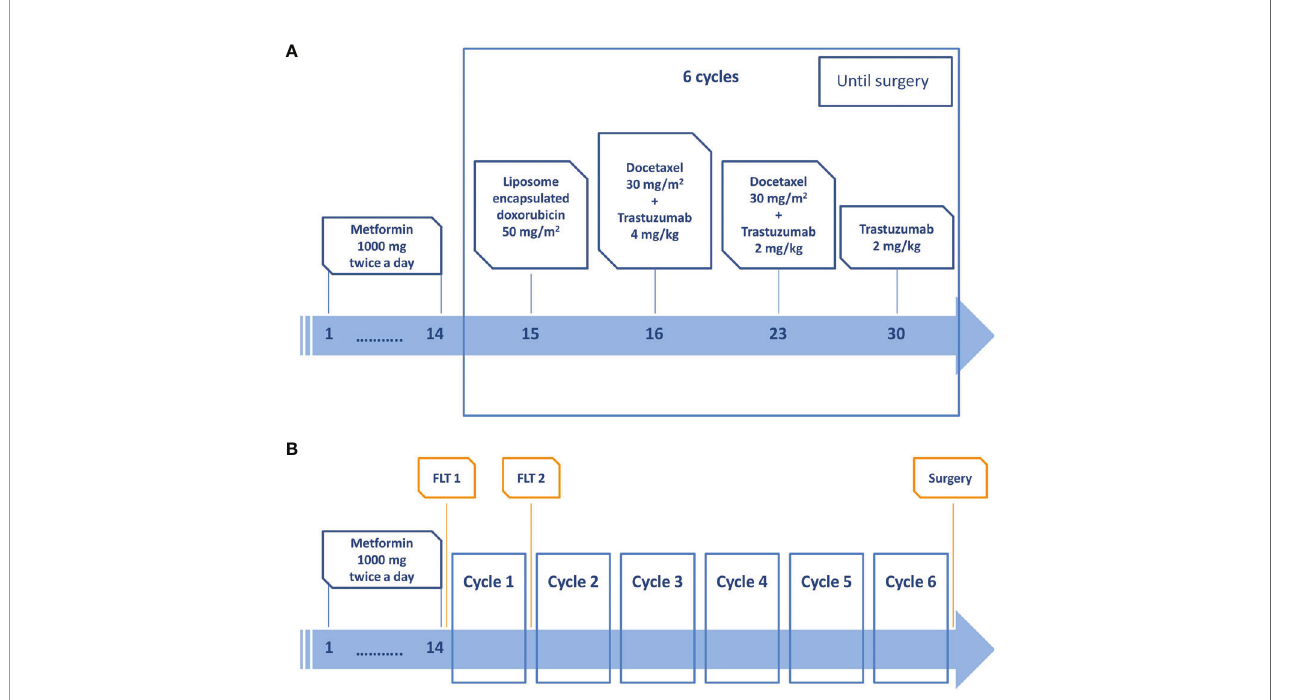
FIGURE 1 | (A) Treatment scheme and timeline. (B) Image acquisition scheme and